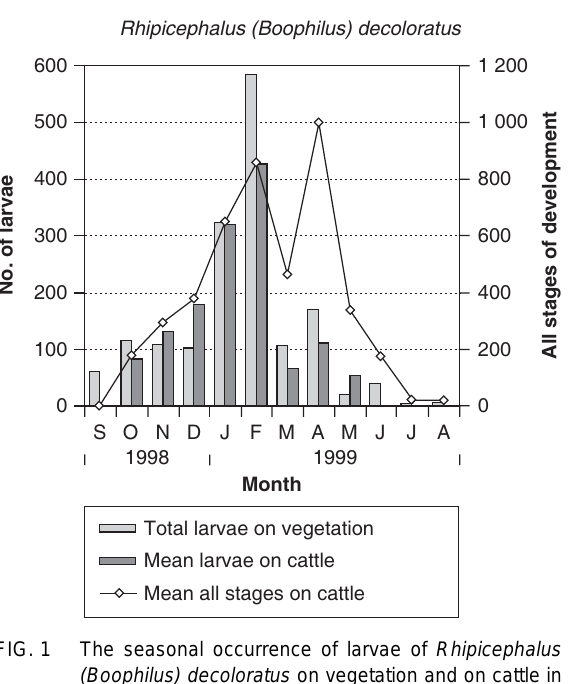
FIG. 1 The seasonal occurrence of larvae of Rhipicephalus (Boophilus) decoloratus on vegetation and on cattle in an eastern region of Free State